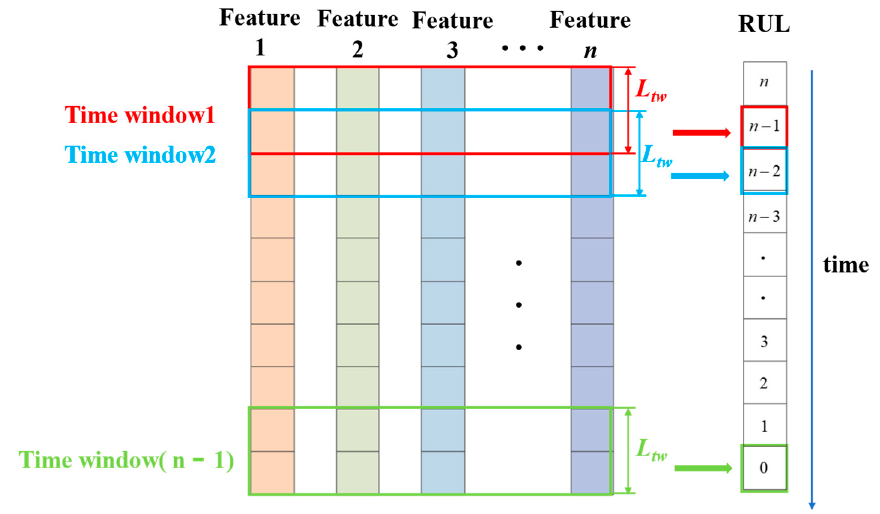
Figure 5. Time-window processing sequence. Table 3. Effect of different time-window lengths.